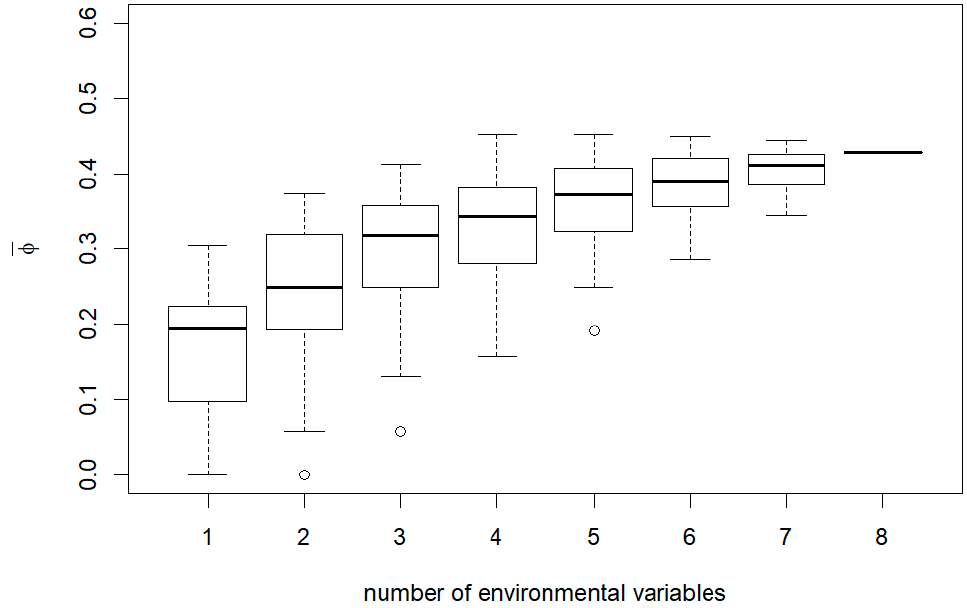
Figure A7. Box plot of mean phi coefficients ( φ ) of the FDMs generated by LR as affected by the number of explanatory variables. Box plot shows median plus upper and lower quartiles for φ of FDMs with a given number of explanatory variables. Minimum and maximum values are indicated by the upper and lower whiskers (1.5 × interquartile range). Circles are outliers.